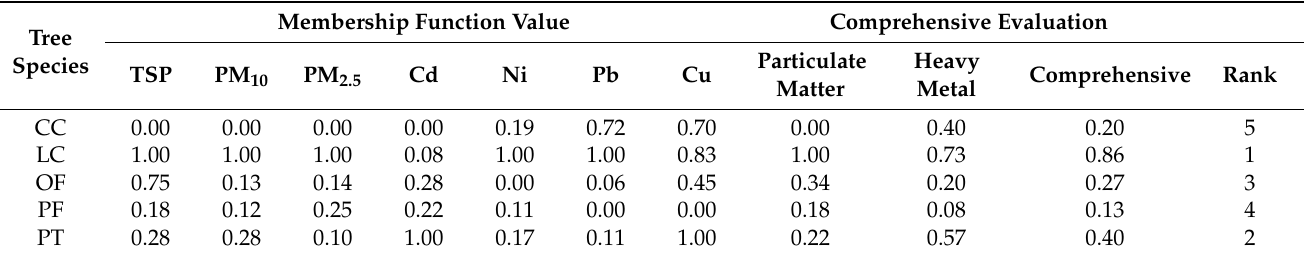
Table 3. A comprehensive evaluation of the capacity of plant leaves to retain particulate matter and accumulate heavy